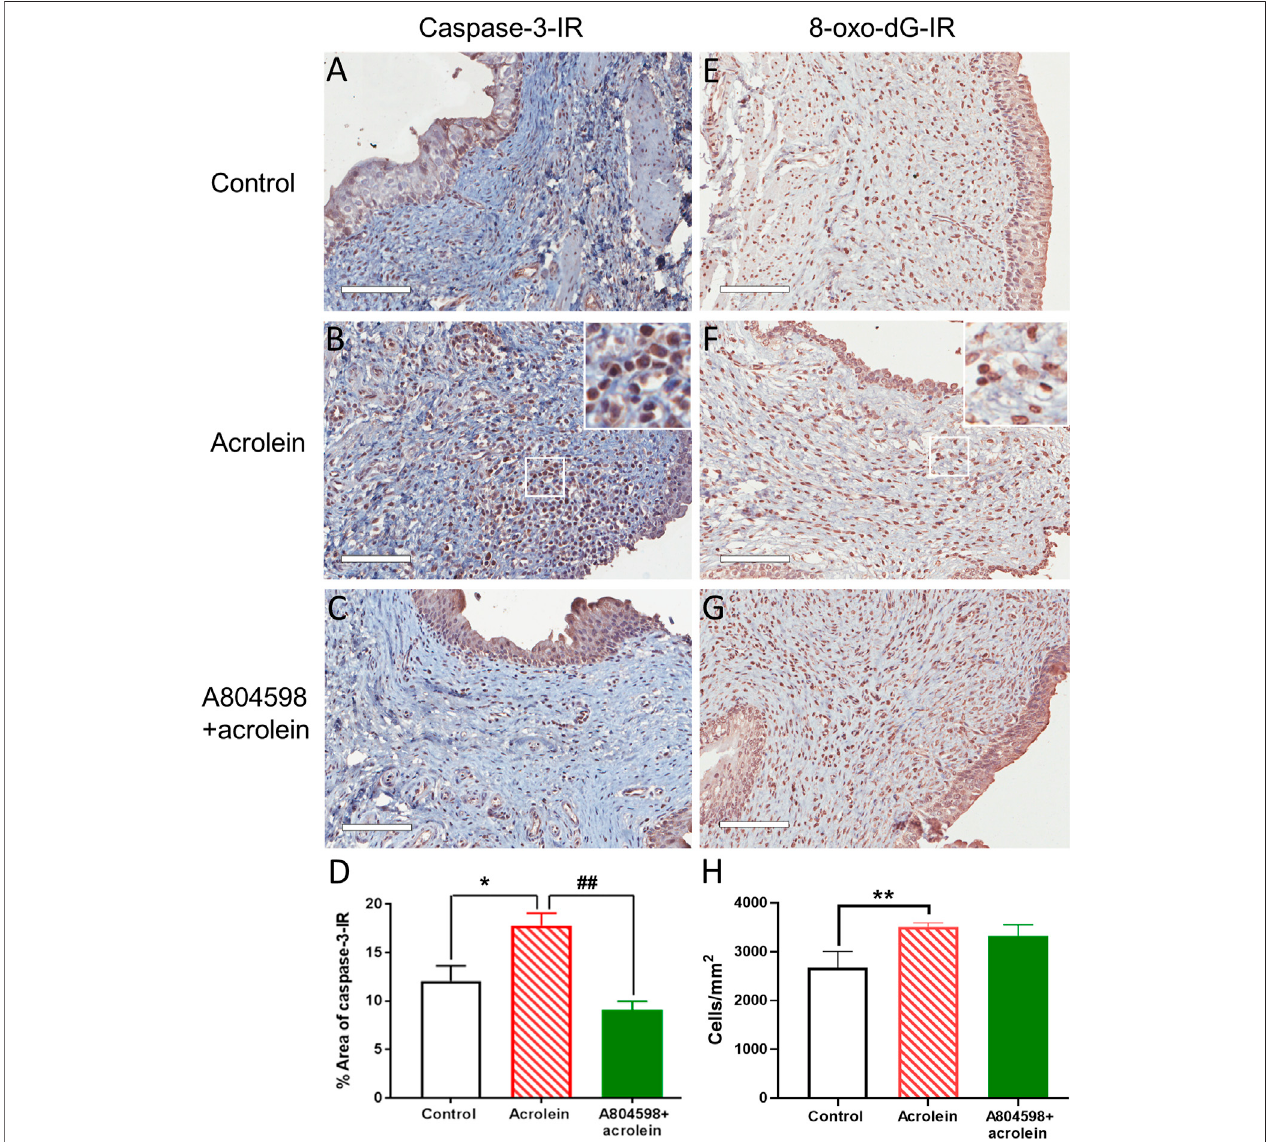
FIGURE 2 | Representative images and quantitative analysis of caspase-3 immunoreactivity and 8-oxo-dG immunoreactivity in the mucosal layer of the porcine bladders. (A,E) Perfusioncontrol. (B,F) Treatedwithacrolein(0.05%). (C,G) TreatedwithA804598(10 μ M)andacrolein(0.05%). (D,H) Quantitativeanalysisofcaspase- 3immunoreactivity(IR)and8-oxo-dG-IR,respectively,inthemucosaoftheporcinebladderswithdifferenttreatmentsusingImageJ.Thedataareshownasmean ± SEM from n (cid:2) 6bladdersincaspase-3-IRand n (cid:2) 5bladdersin8-oxo-dG-IR,foreachgroup.Signi fi cancewasdeterminedbyone-wayANOVAwithBonferronitest.* p < 0.05 and ** p < 0.01 compared to the acrolein-treated group. Scale bars (cid:2) 100 μ m. High power image inserts are enlargements of regions outlined in (B,F) , and many caspase-3-IR and 8-oxo-dG-IR positive cells with brown-stained nuclei are present.